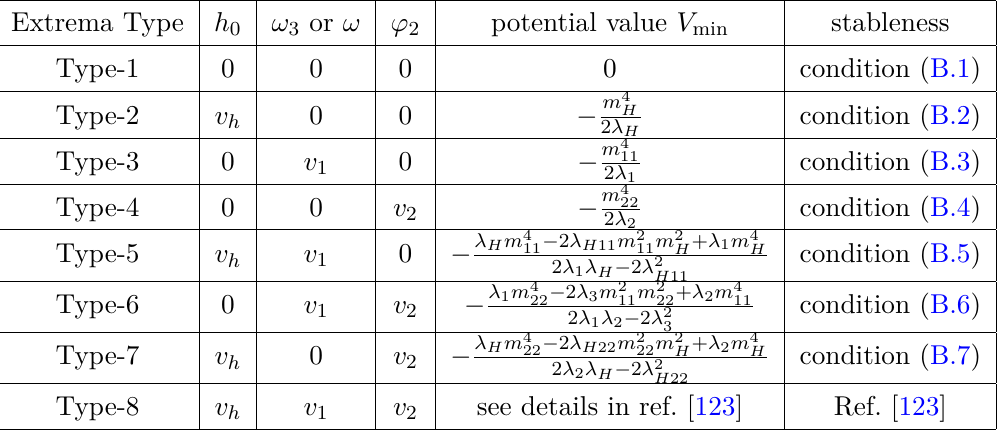
Table 3. Eight possible types of stable vacuum extrema in the three VEVs scenario.